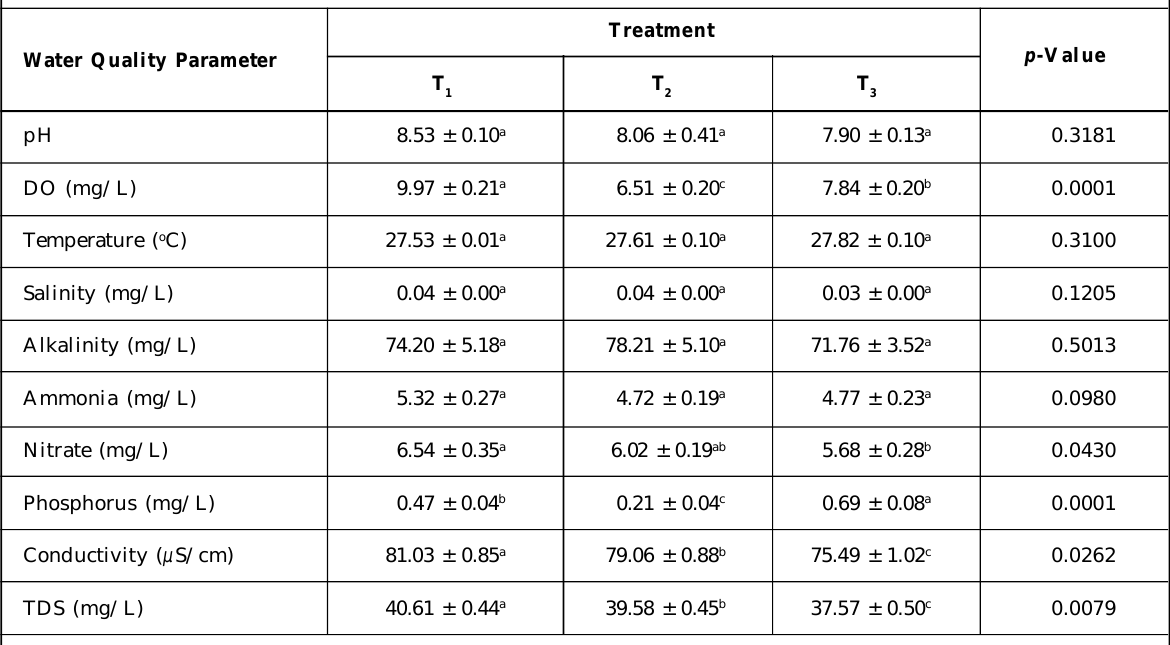
Table 1: Comparison of water quality parameters in concrete tanks under three different treatments